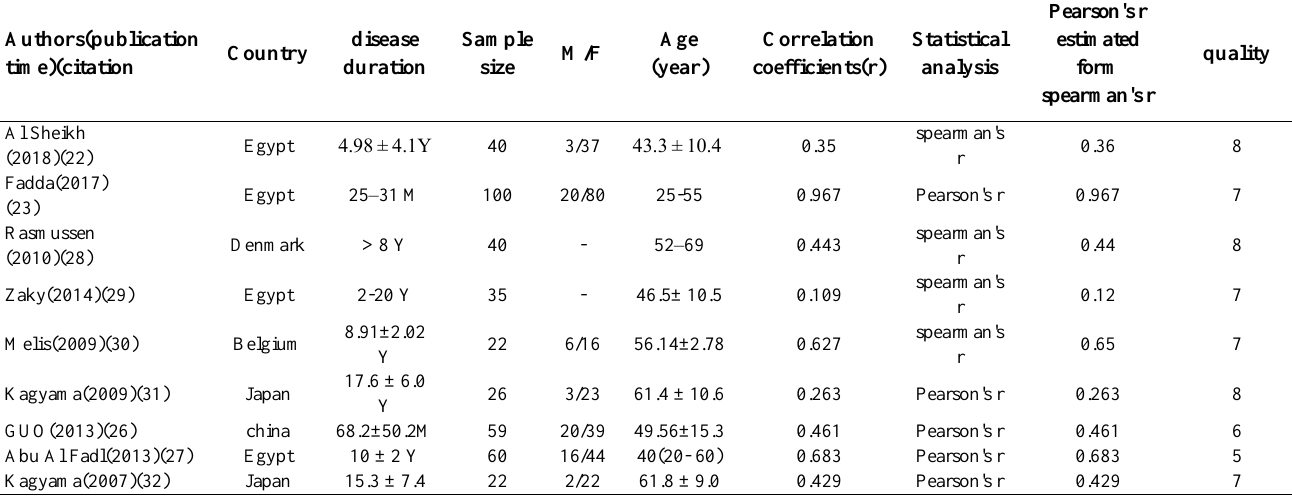
Table2 : Characteristics of included studies that associated interleukin 23 with Rheumatoid